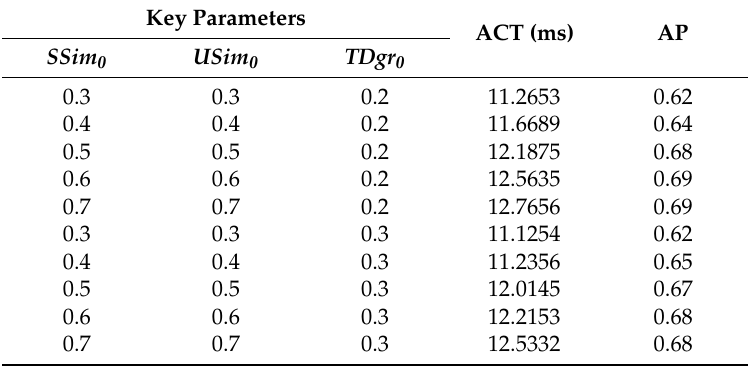
Table 1. Comparison with different values of the key parameters in CSDRM. Key Parameters